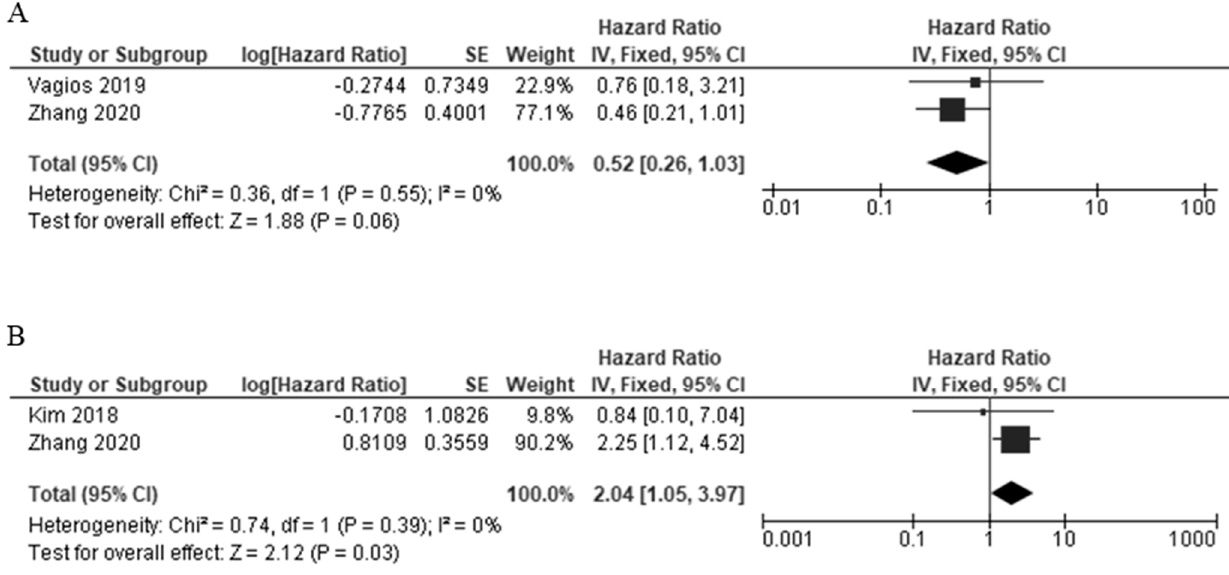
Figure 6. The forest plots of the studies evaluating the hazard ratio (HR) and 95% confidence inter- val (CI) of high PD-L1 expression in EC [17,24,32]. ( A ) Forest plots of overall survival (OS) in TCs. ( B ) Forest plots of overall survival (OS) in ICs. ( B ) Forest plots of overall survival (OS) in